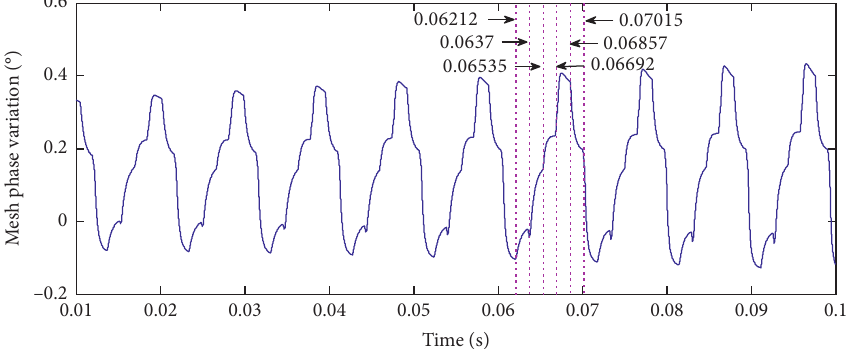
Figure 14: Meshing phase variation of s- p